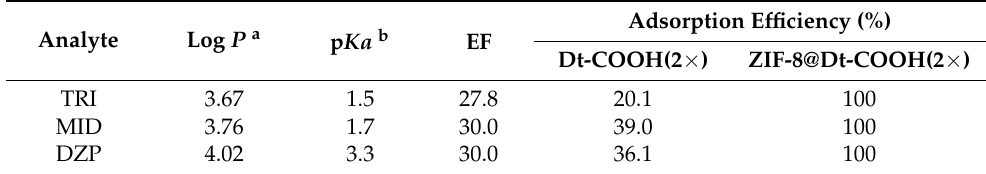
Table 1. Log P and p Ka of the analytes and EF, adsorption efficiency of the proposed materials for BZDs. Analyte Log P a p Ka b